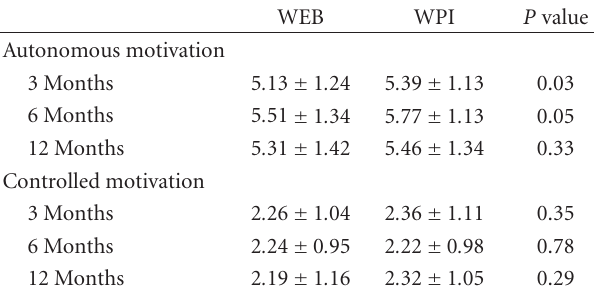
Table 2: Motivation by intervention